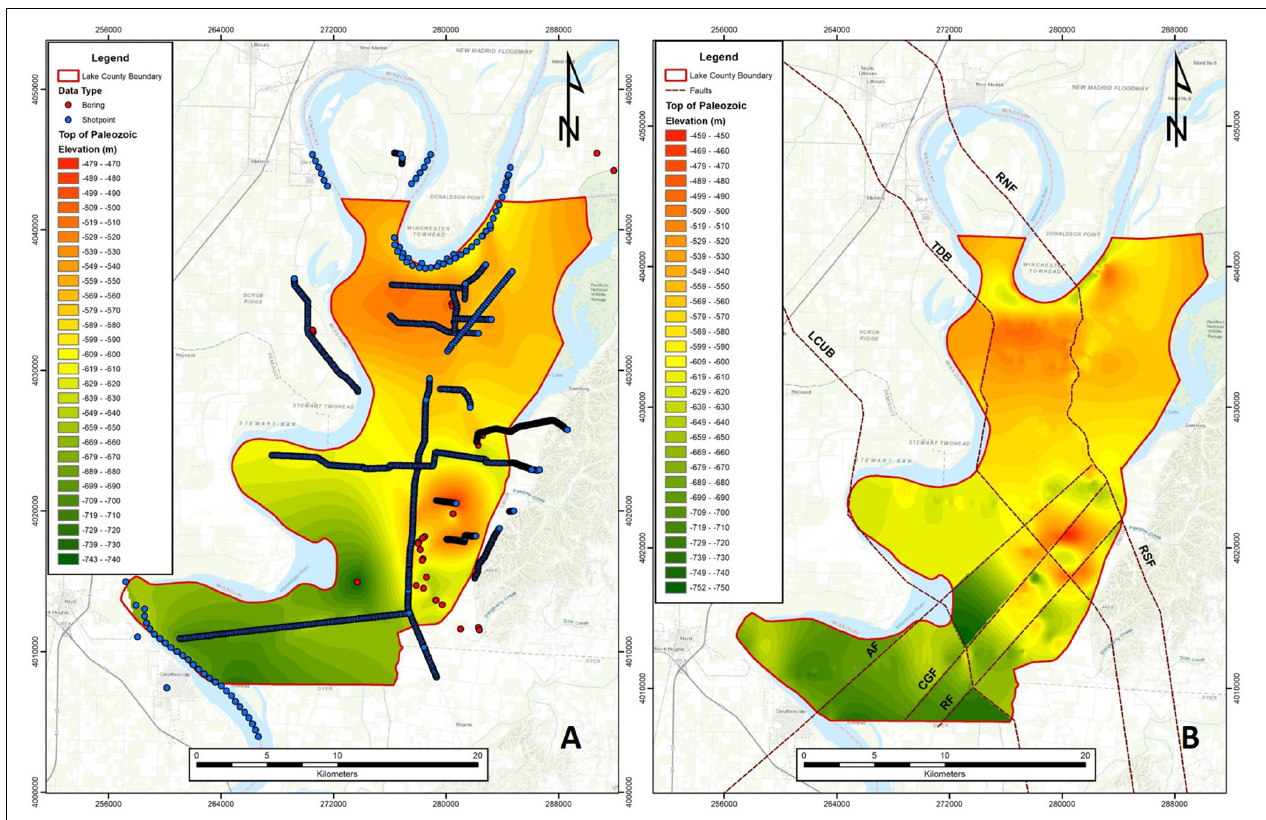
FIGURE 7 | (A) Structure contour map of the top of the Paleozoic strata. (B) Faulted structure contour map of the top of the Paleozoic strata. AF, Axial; CGF, Cottonwood Grove; RF, Ridgely; RNF, Reelfoot North; RSF, Reelfoot South; TDB, Tiptonville dome back thrust; LCUB, Lake County uplift back thrust faults. Contour interval is 10